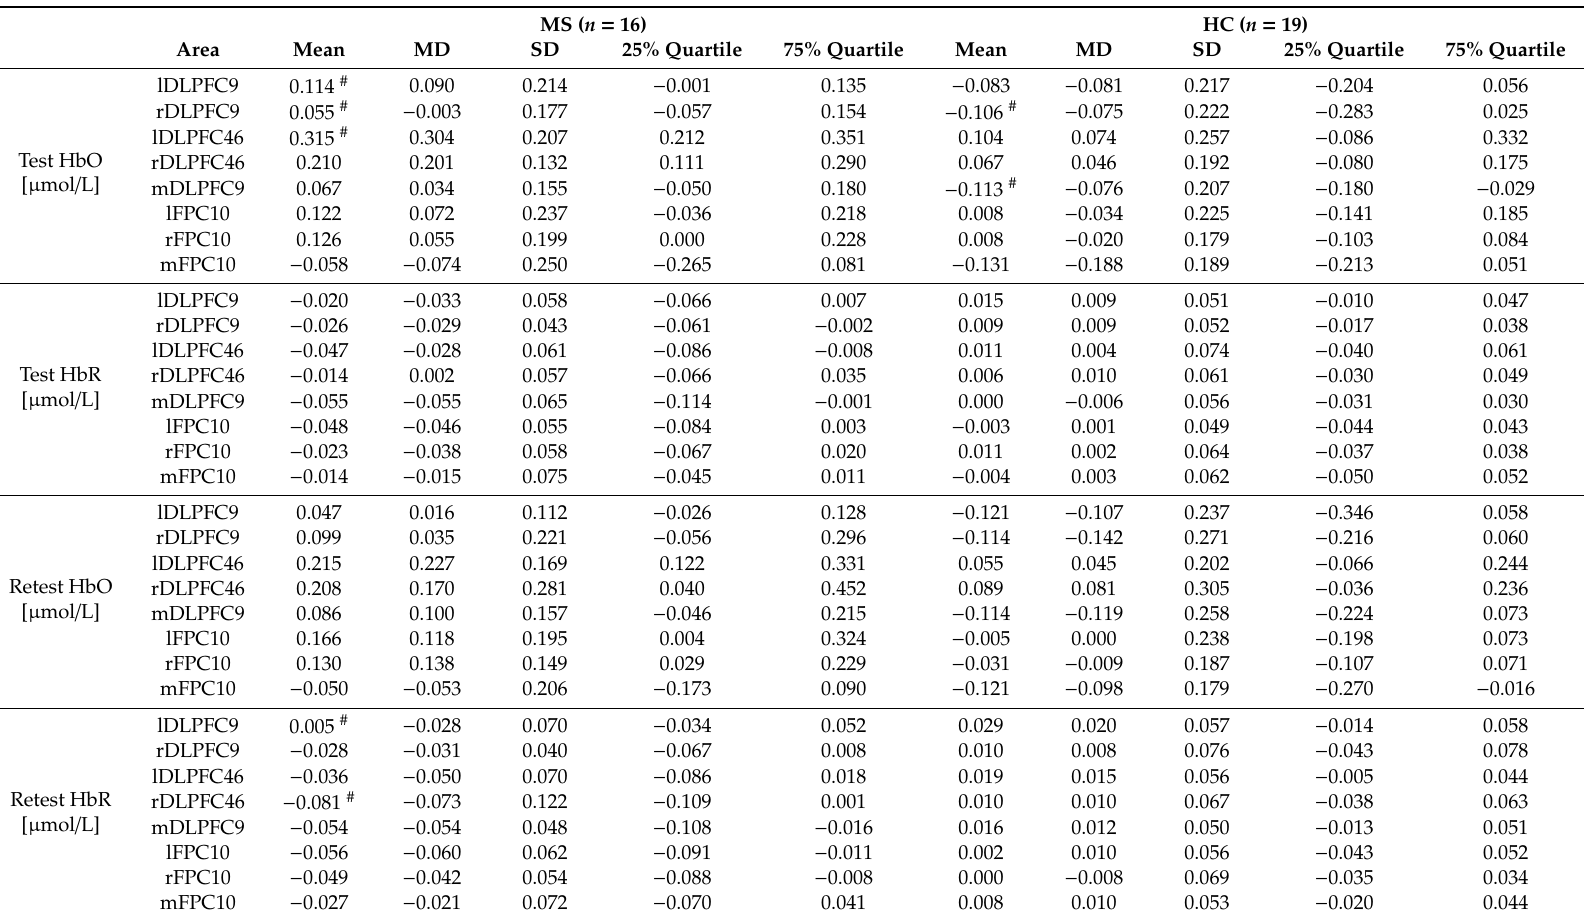
Table 2. Test and retest overall mean cHbO / cHbR for both groups (MS /